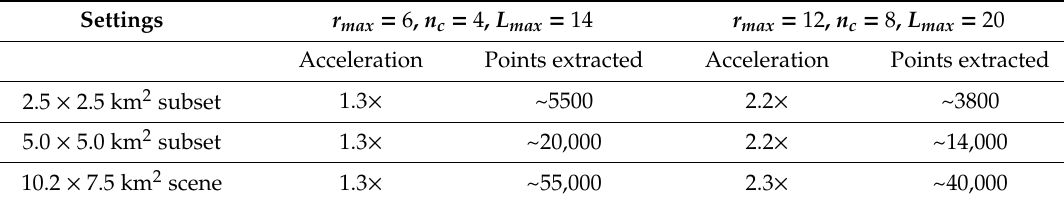
Table 6. Comparison of processing speed and number of extracted contour points in adaptive vs non-adaptive GGC for di ff erently sized areas. Processing acceleration indicates the reduction in processing time of the adaptive version in relation to the non-adaptive